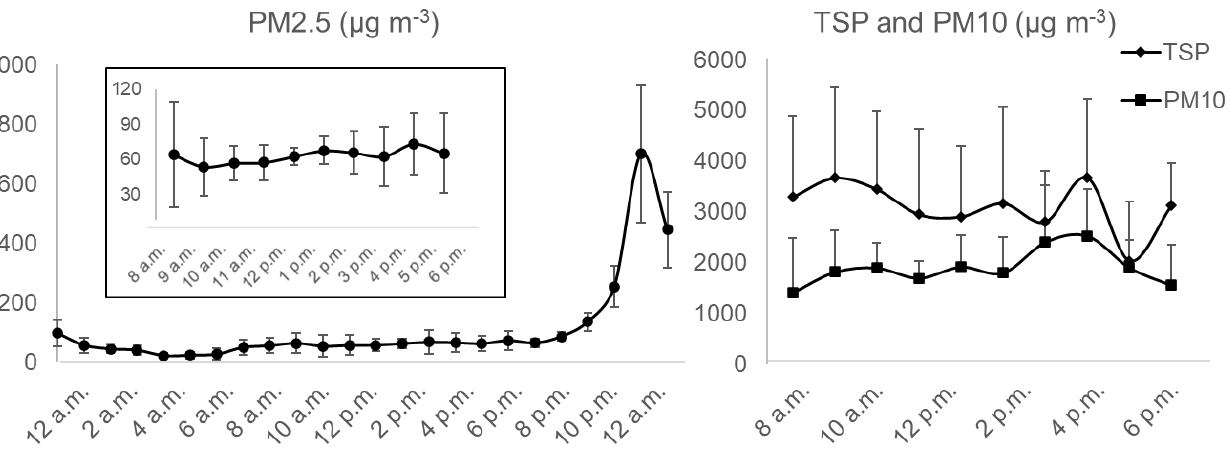
Figure 3. Mean diurnal TSP, PM 10 , and PM 2.5 concentrations ( µ g m − 3 ) during sampling hours in Station 1 of Feedlot C.